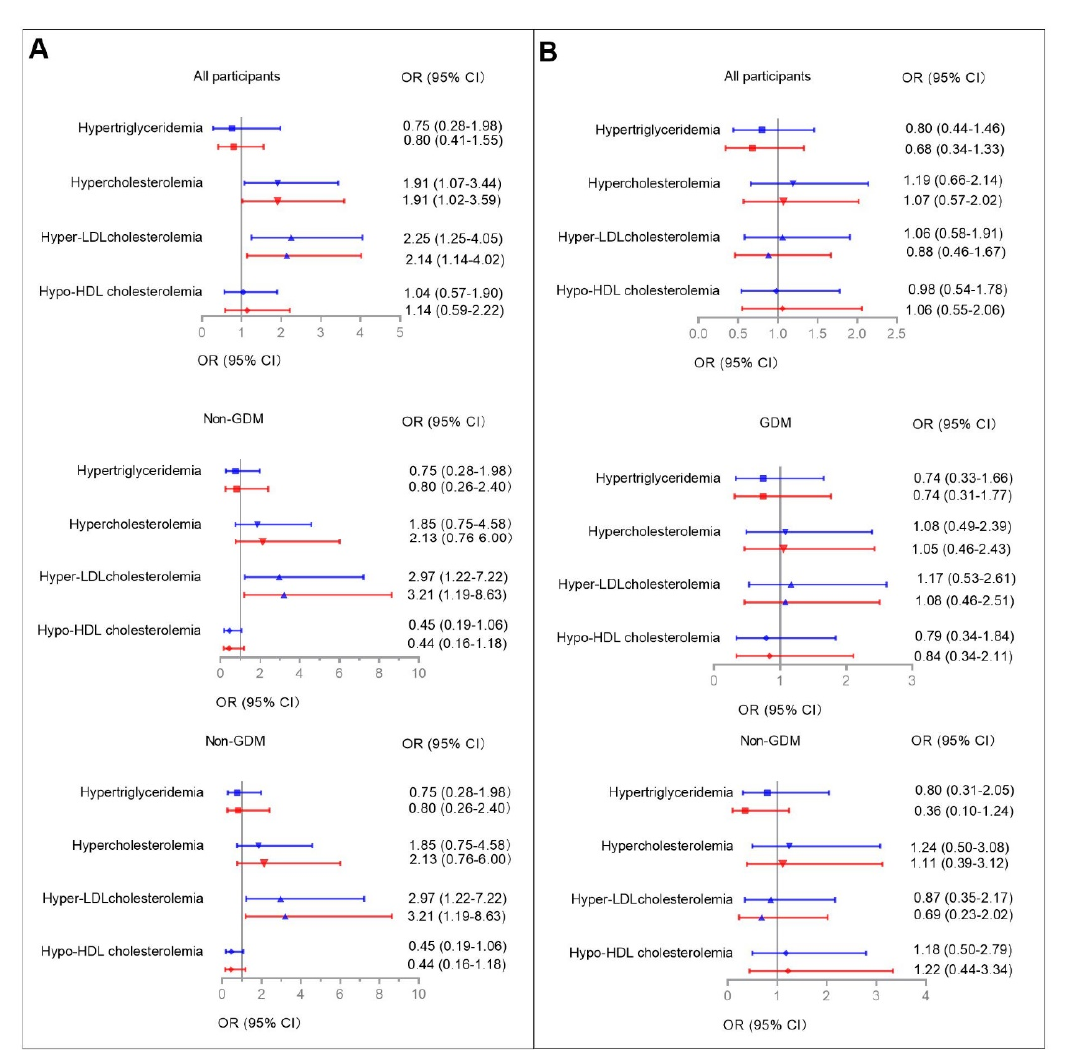
Figure 3. Associations between higher serum aspartame ( A ) and sucralose ( B ) levels with dyslipidemia during pregnancy. Multiple logistic regression models were used to determine the associations between higher serum aspartame and sucralose levels with dyslipidemia among all participants and among those with and without GDM, respectively. Covariates for fully adjusted models are as stated in the legend for Figure 2. Blue and red lines indicate ORs (95% CIs) before and after full adjustments, respectively. Reference: Women without lower serum aspartame/sucralose levels among all participants, and among those with and without GDM, respectively. Results were considered significant associations if the 95% CIs did not contain 0.